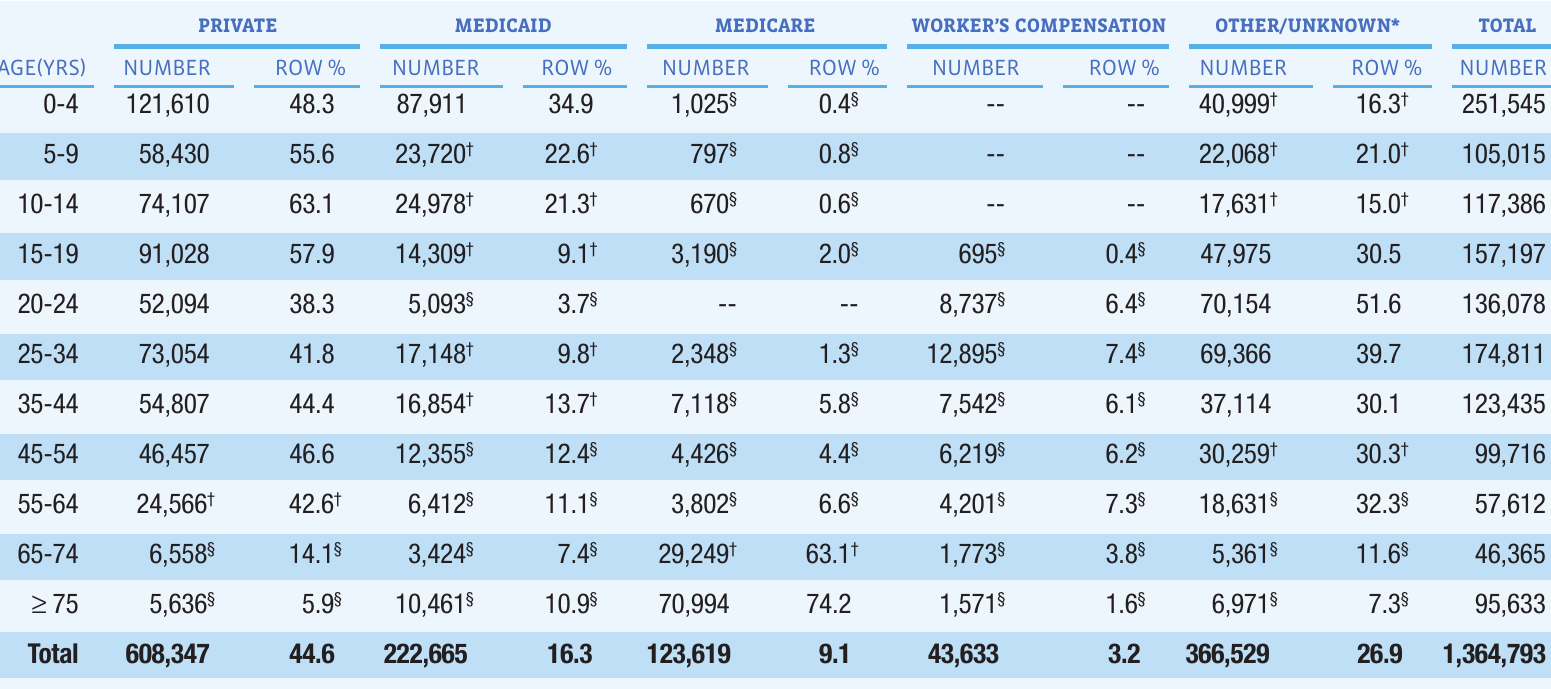
TABLE 7: Estimated Average Annual Numbers and Percentages of Traumatic Brain Injury-Related Emergency Department Visits, by Age Group and Expected Source of Payment, United States,